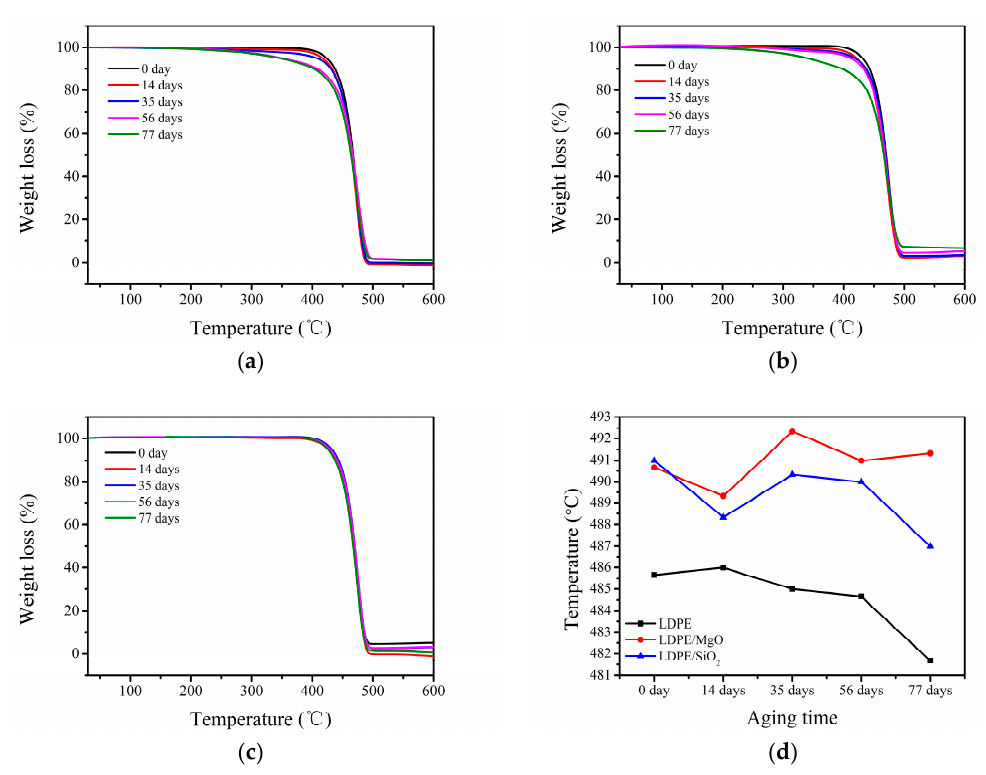
Figure 3. Thermogravimetric analysis (TGA) curves of neat LDPE and 1 wt %-nanocomposites with different aging times ( a ) TGA curve of neat LDPE; ( b ) TGA curve of LDPE/SiO 2 nanocomposites; ( c ) TGA curve of LDPE/MgO nanocomposites; ( d ) temperature at 5% mass loss of all samples.